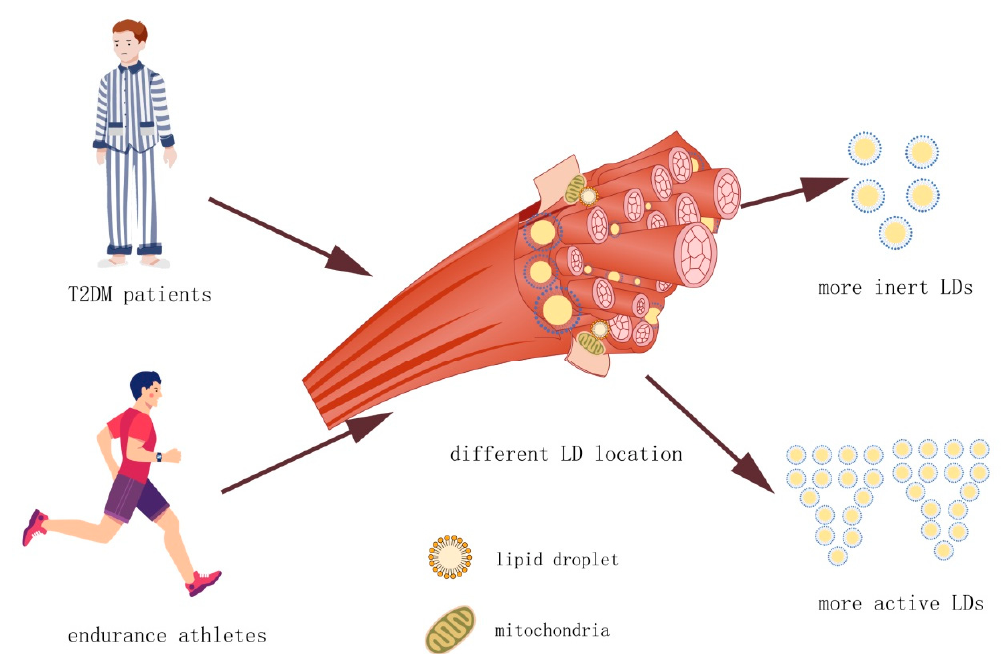
Figure 2. Size and location of LDs in skeletal muscle. Endurance athletes have the same amount of intermyofibrillar lipid in their skeletal muscle LDs as type 2 diabetes mellitus (T2DM) patients. However, their LDs are smaller in volume than the LDs in the skeletal muscle of T2DM and, therefore, the larger surface area provides higher lipolysis activity. The LDs of endurance athletes may also be contacted with mitochondria more than LDs in the skeletal muscle of T2DM, which provides the required energy for skeletal muscle with higher efficiency.